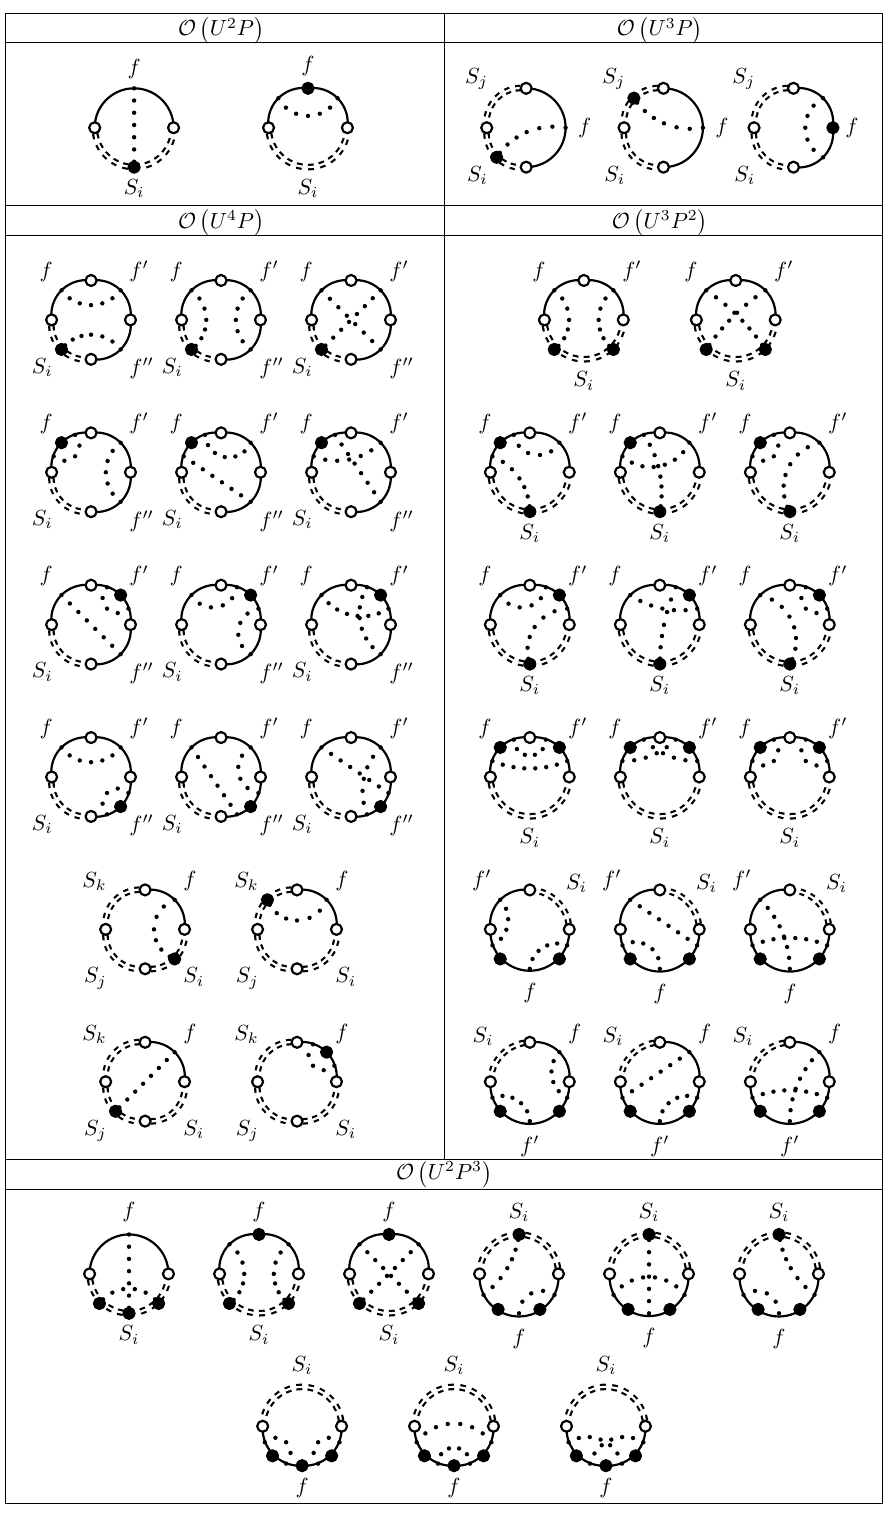
Table 5 . Covariant diagrams containing powers of both U and P contributing to operators up to dimension 6. In total we have 47